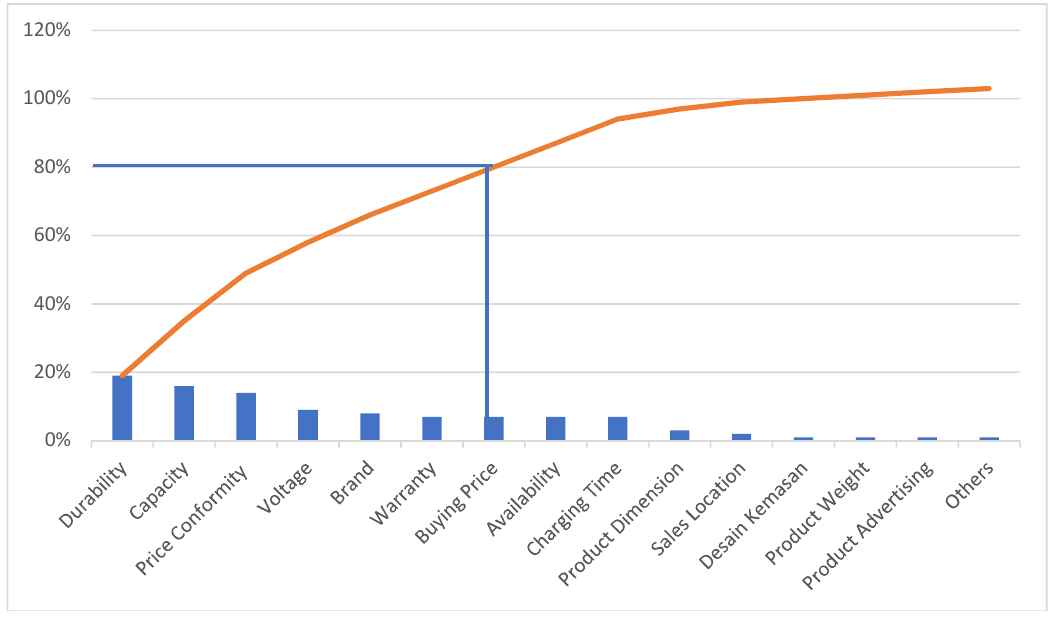
Figure 2. Pareto Chart for Consumer Preferences [14].